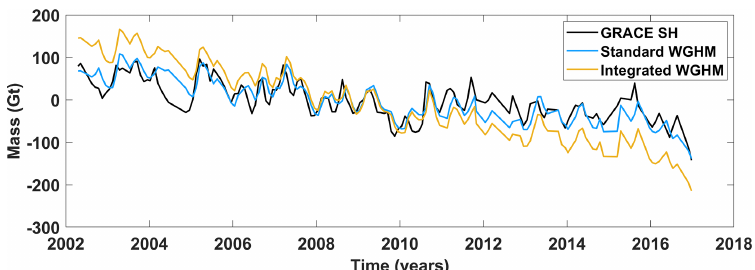
Figure 5. Basin-averaged time series from GRACE SH, standard WGHM, and integrated WGHM for the Indus Basin.